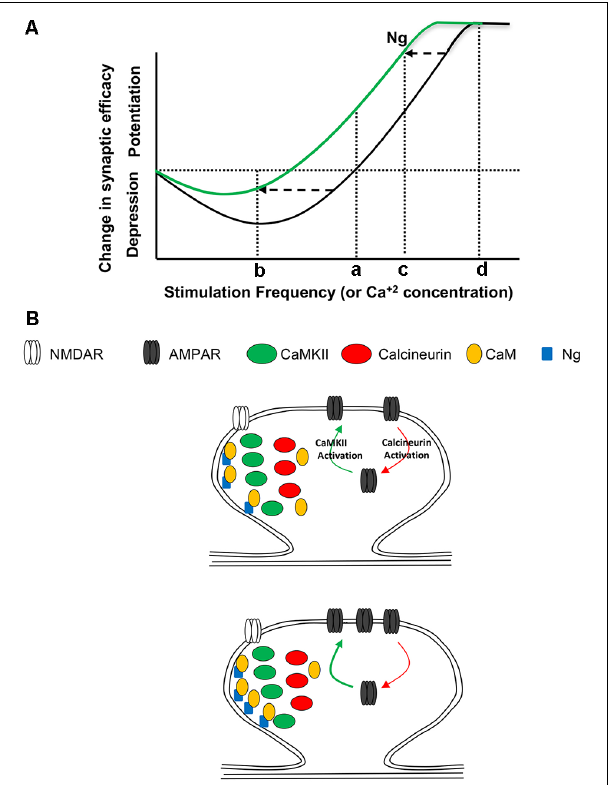
changes in synaptic plasticity strength in response to various stimulation frequencies. Under normal conditions (black line), low-frequency stimulation (b) results in depression, while high-frequency stimulation (c) results in potentiation. Only a few things have been found to slide the whole curve; see “Discussion” section for details. This metaplasticity is similar to that described by the “sliding threshold” feature of the Bienenstock, Cooper and Munro model (BCM theory) of experience-dependent synaptic plasticity. This theoretical diagram resembles Figure 2 . The various postsynaptic depolarization protocols used, represented by 1, 2 and 3 in Figure 2 , are schematically equivalent to the stimulation frequencies b, c, and d, respectively. (B) A working model for Ng regulation of metaplasticity. (Top) While CaMKII, similar to Ng, concentrates closer to the plasma membrane, calcineurin concentrates away from the plasma membrane. Both CaMKII and calcineurin require Ca 2 + and CaM to be activated. The activation of CaMKII results in the insertion of AMPA receptors and thus the expression of long-term potentiation (LTP). On the other hand, the activation of calcineurin results in the removal of AMPA receptors and thus the expression of LTD. (Bottom) Increasing Ng does not change the ultrastructural localization of CaMKII or calcineurin. Nonetheless, increasing Ng targets more CaM closer to the plasma membrane, where there is more CaMKII; thus increasing the chance of CaMKII activation, while decreasing the chance of CaN activation. This may explain, at least partly, why Ng shifts the synaptic plasticity curve to the left (i.e., regulating